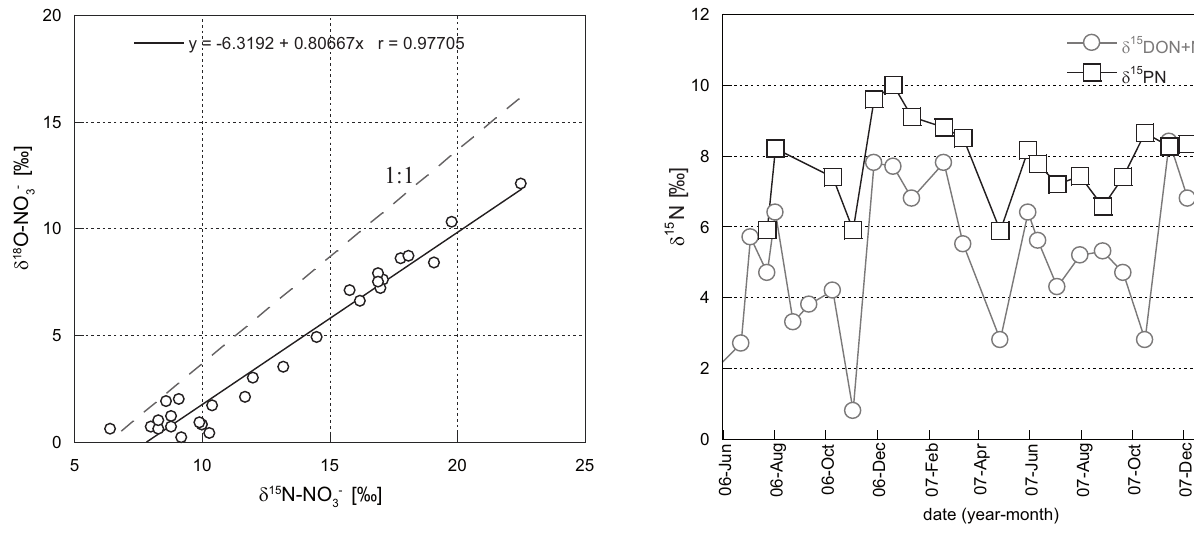
and δ 15 PN in the Elbe River at the weir of 4